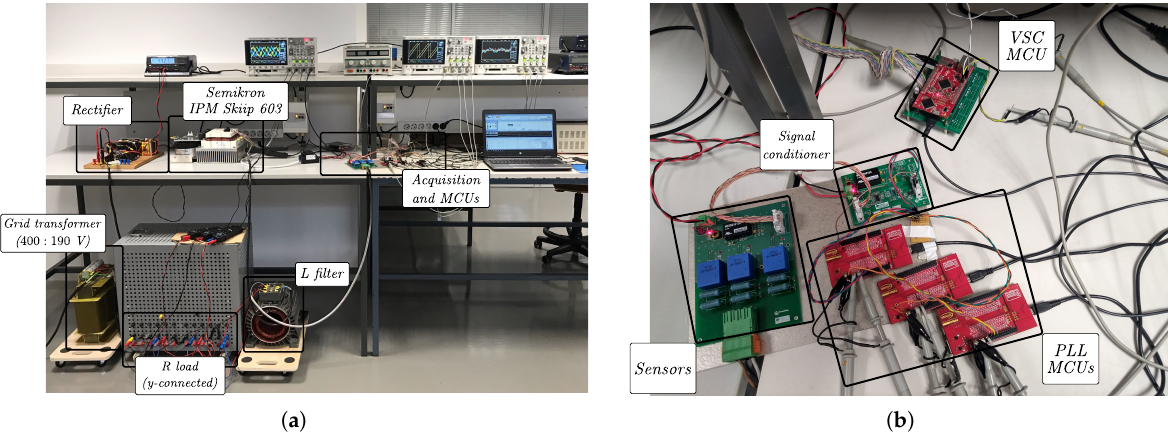
Figure 17. Laboratory setup for three-phase voltage generation and evaluation of the PLL’s performance. ( a ) shows the full setup and ( b ) the acquisition board, conditioning board, and